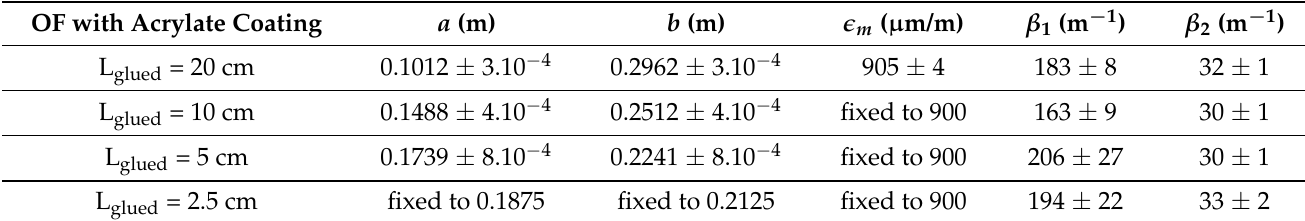
Table 3. Fitting parameters obtained for the sample instrumented by acrylate coated